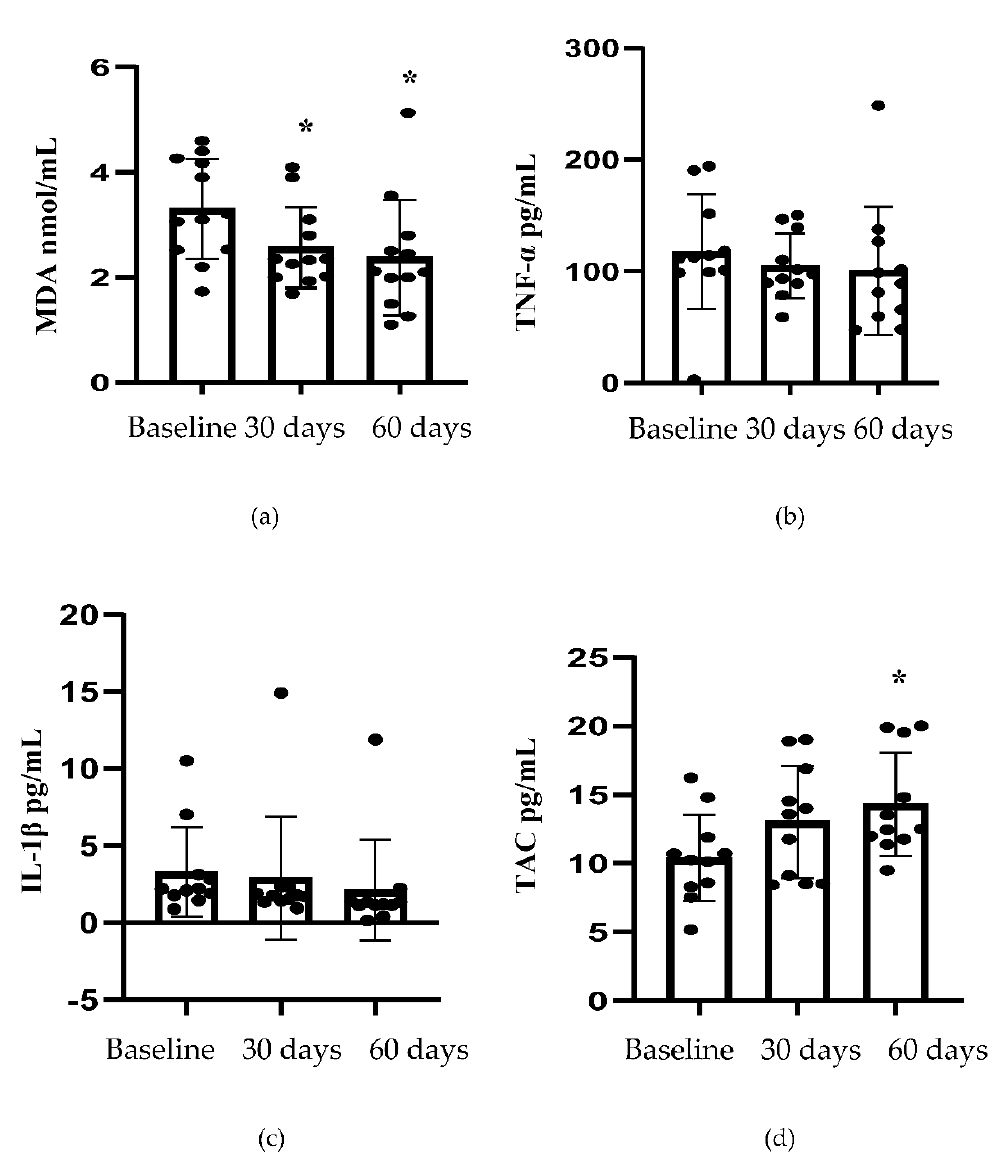
Figure 2. ( a – d ) show the levels of Malondialdehyde (MDA), tumor necrosis factor- α (TNF- α ), interleukin-1 β (IL-1 β ) and total antioxidant capacity (TCA) at different time points, in patients with T1D. Data are presented as means ± SD. Signs ( * ) on the top of each time point are indicators of significant p values ( p < 0.05) of pairwise comparisons. The comparisons between the two time points and their significant values were assessed by using the post hoc Bonferroni test.